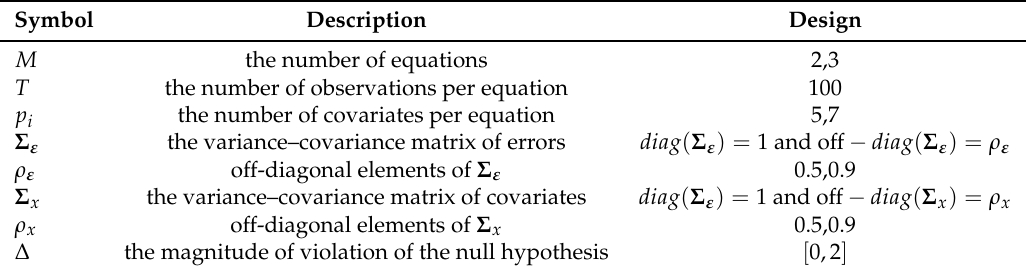
Table 1 provides notations and a symbol key for the benefit of the reader. Table 1. Values and explanations of the